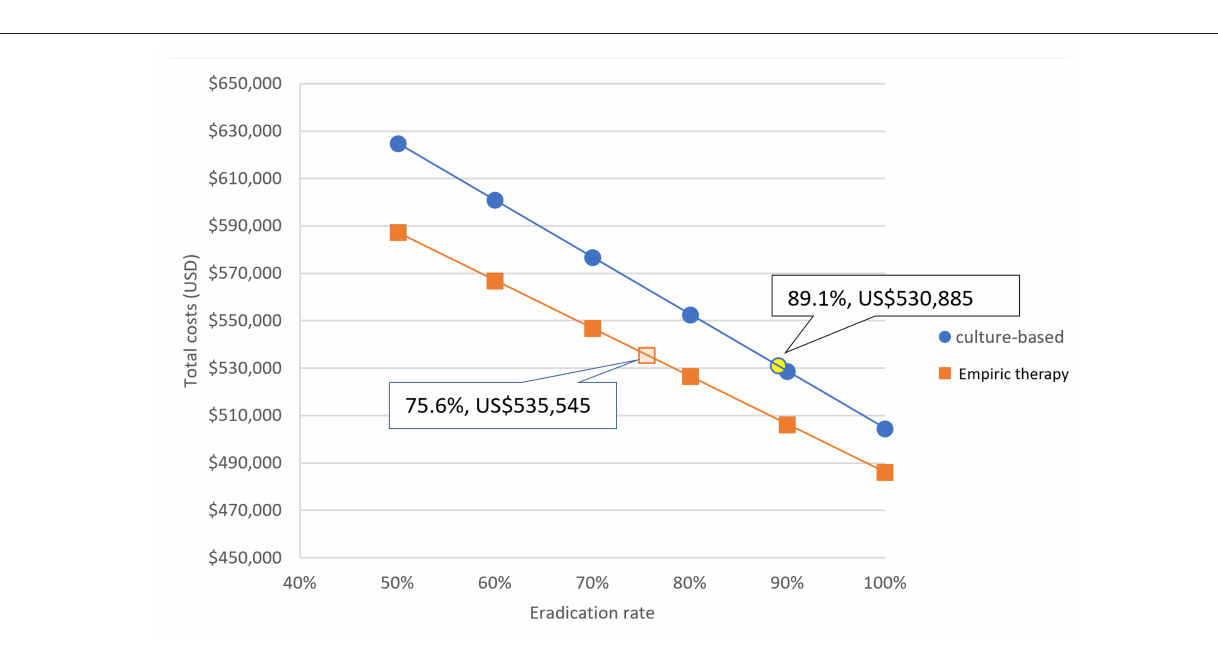
FIGURE 4 | The impact of eradication rate on the costs of the two eradication strategies. For every 10% increase in successful eradication rate, the total cost was reduced by US$24,058 with a culture-based strategy and by US$20,241 with an empiric therapy strategy (Both indicated successful eradication rates and costs are our